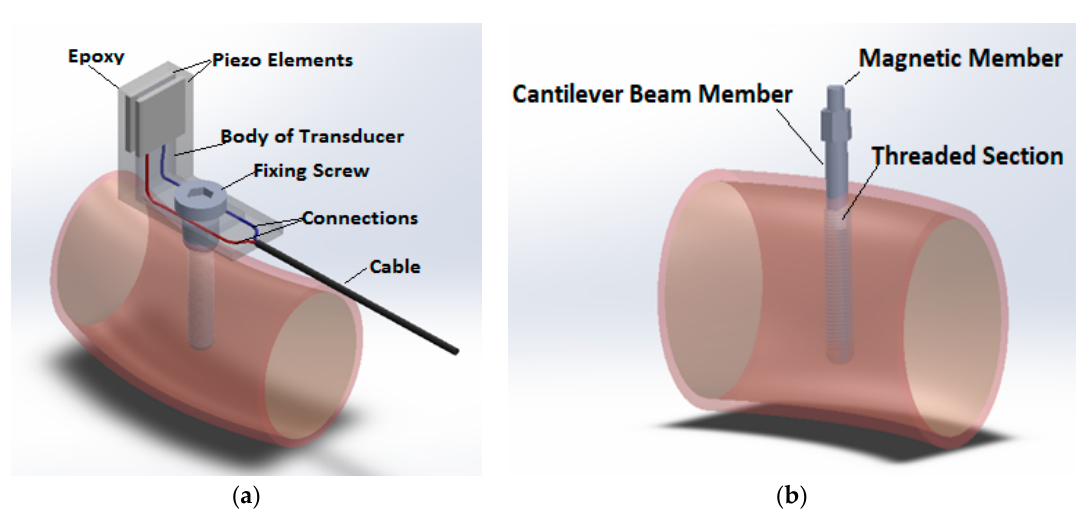
Figure 4. Osstell devices: ( a ) the former L-shaped sensor; ( b ) the following Osstell